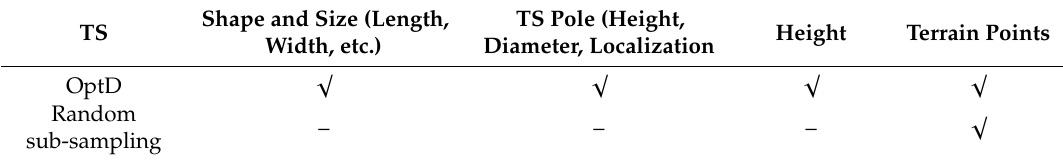
Table 10. Information about TS preserved after data reduction.